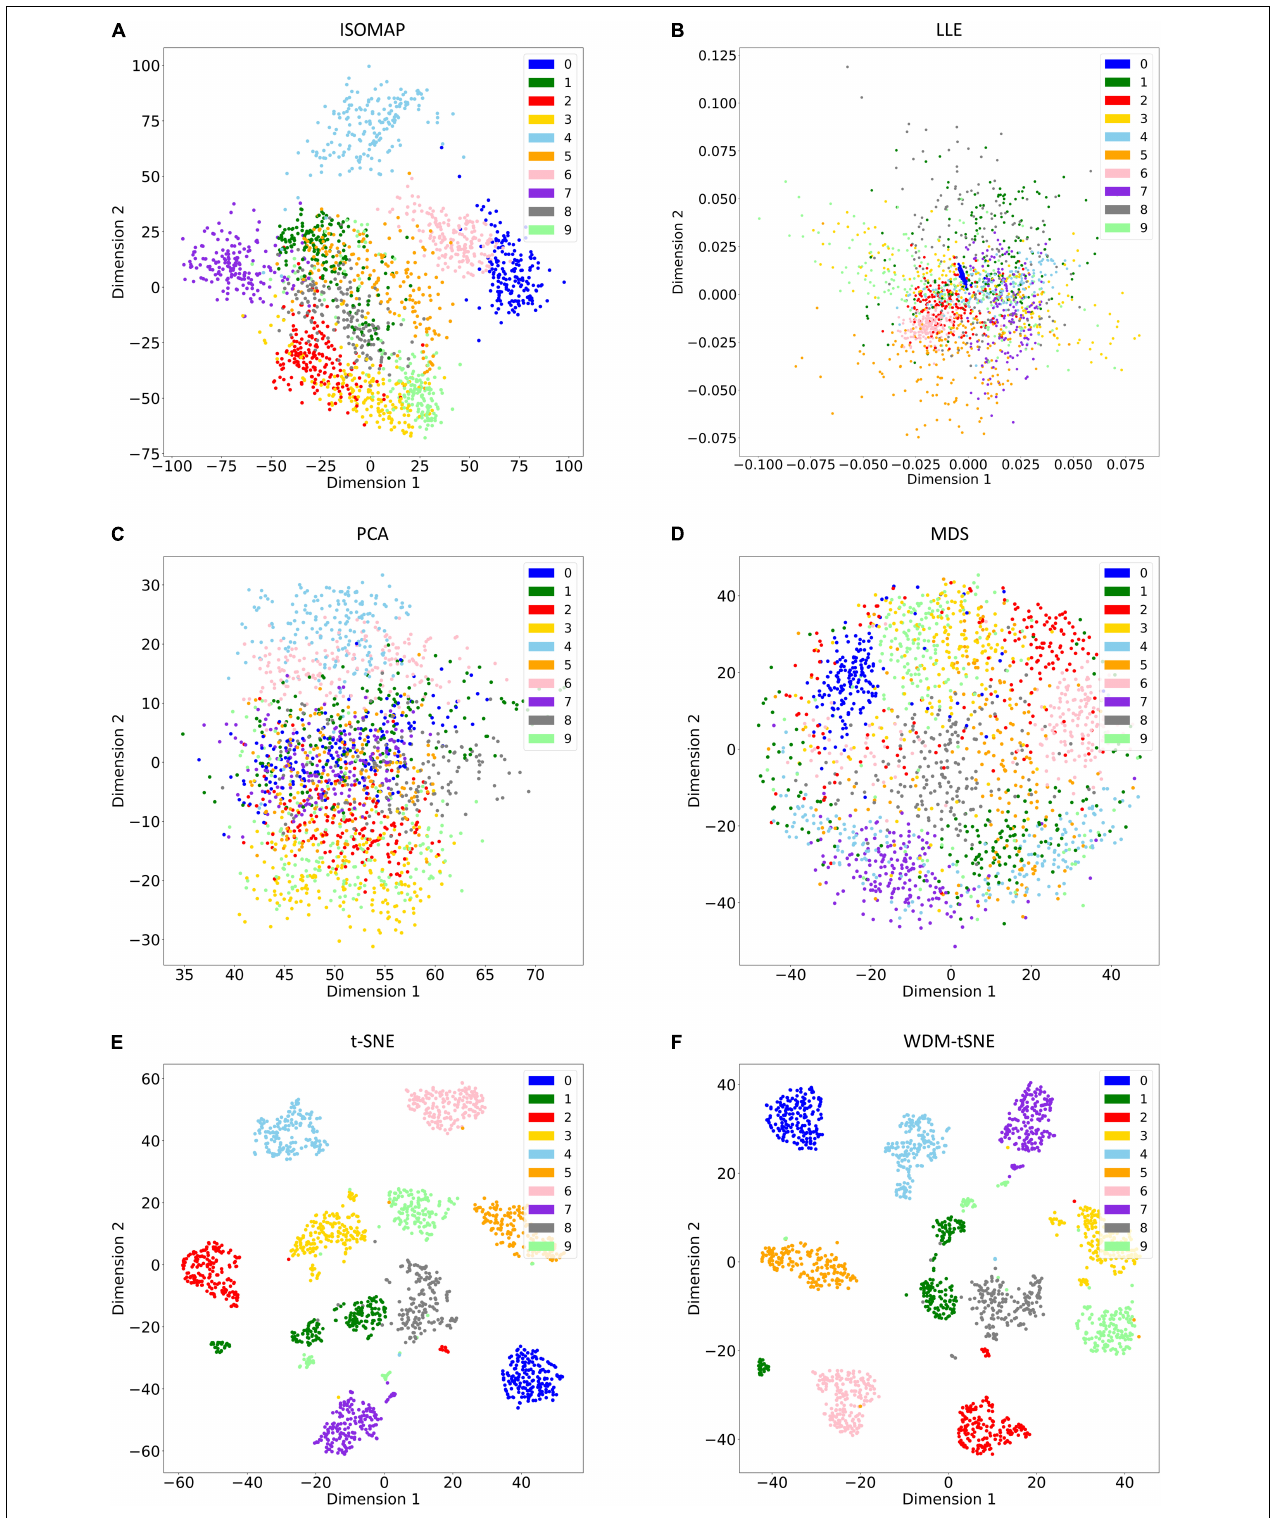
FIGURE 5 | The plots for the MNIST dataset based on six dimensionality reduction approaches, including (A) Isomap, (B) LLE, (C) PCA, (D) MDS, (E) t-SNE, and (F) WDM-tSNE. MNIST, Modified National Institute of Standards and Technology; ISOMAP, Isometric Mapping; PCA, Principal Component Analysis; LLE, Locally Linear Embedding; MDS, Multidimensional Scaling; t-SNE, t-Distributed Stochastic Neighbor Embedding; WDM-tSNE, Weighted Distance Metric and the t-stochastic neighbor embedding algorithm.